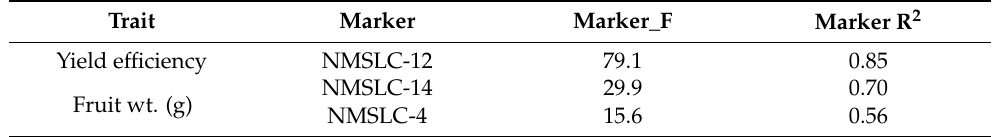
Table 5. Marker trait association in five mango varieties grafted on three polyembryonic rootstocks with generalized linear model (GLM) approach ( p <